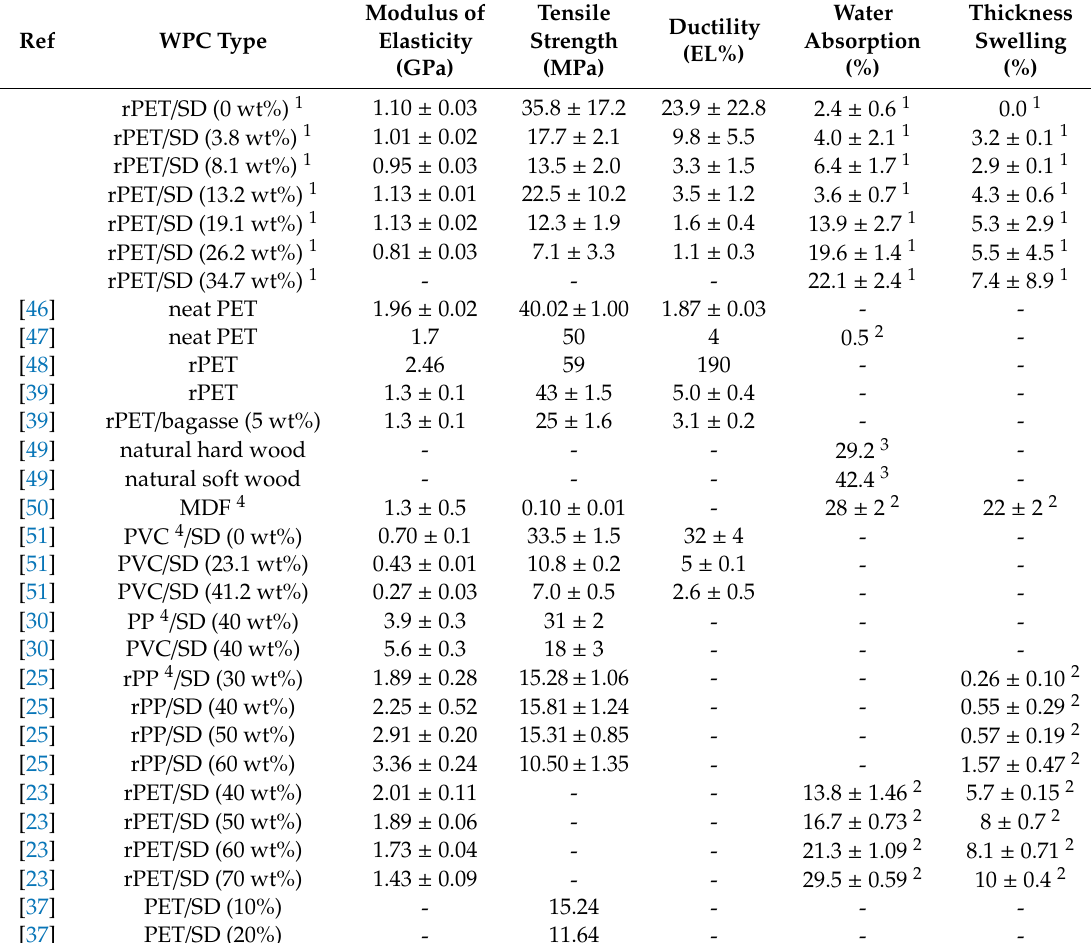
Table 5. Comparison of sample rPET WPC properties with literature